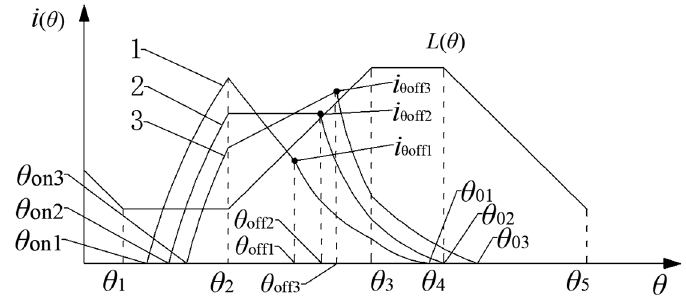
Figure 2. Current waveform of linear inductance model with different turn-on angles.